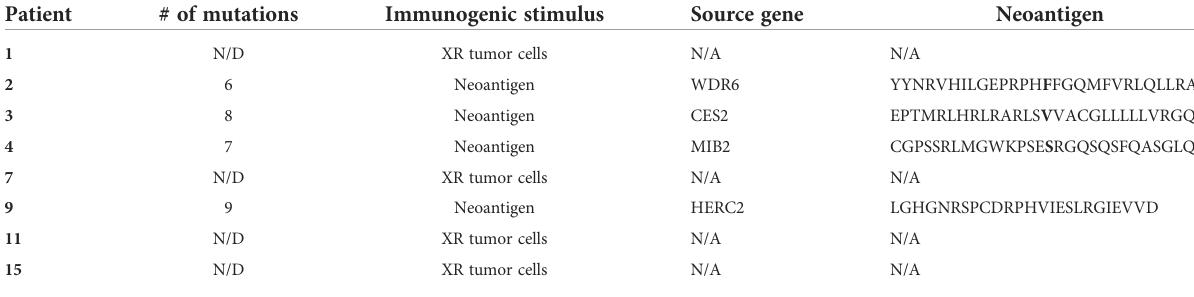
TABLE 1 Characteristics of immunogenic stimulus and neoantigens